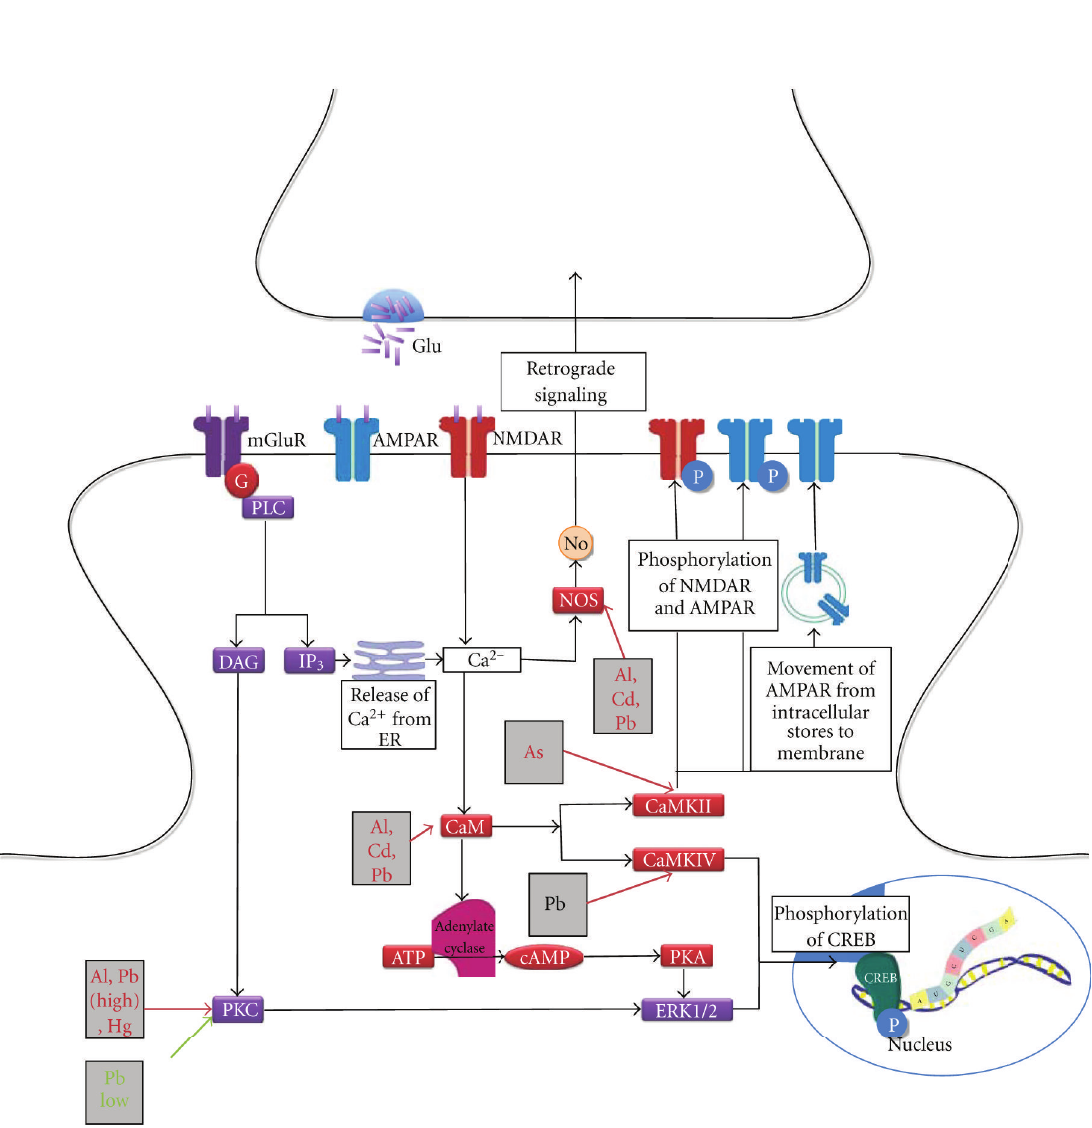
Figure 5: Proteins involved in the formation of long-term potentiation (LTP) and toxic e ff ects of metals. LTP consists of di ff erent forms: early-phase LTP (E-LTP), which lasts only a few hours, and late-phase LTP (L-LTP), which lasts for several days. E-LTP includes short- term potentiation (STP), which is dependent on NMDA receptor activation and Ca 2+ /calmodulin and LTP-1 that involves protein kinase C (PKC) and Ca 2+ /calmodulin-dependent protein kinase- (CaMK-) dependent phosphorylation. While STP can be formed by activation of NMDA and calmodulin dependent enzymes, LTP-1 requires activation of PKC via DAG that is produced after the activation of mGluRs. PKC and CaMKII then phosphorylate AMPA and NMDA receptors. L-LTP consists of the later phases of LTP, which are LTP-2 and LTP-3. LTP-2 requires synthesis of new proteins and receptors whereas LTP3 requires gene transcription. Activation of adenylate cyclase and cAMP- dependent activation of PKA are required for the formation of the later phases of LTP. LTP-3 depends on the activation of extracellular signal- related kinase 1/2 (ERK1/2) and CaM kinase IV, which in turn phosphorylate CREB and lead to new protein synthesis. Other factors such as p38 mitogen-activated protein kinase (p38 MAPK) leads to the formation of long-term depression (LTD). Several of the molecules required to produce these di ff erent forms of LTP have been identified and are targets for metal toxicity, which have been shown (red arrows indicate inhibition whereas green arrows indicate activation by metals. Black arrows indicate activation that occurs during normal formation of